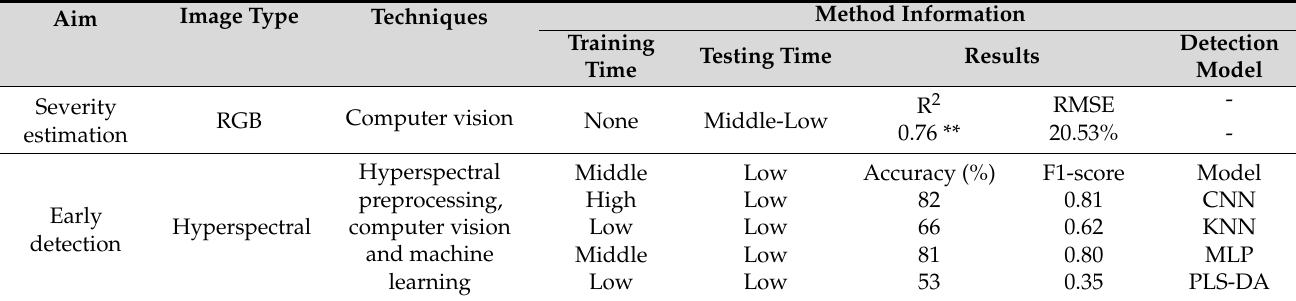
Table 1. Methods and results of severity estimation and early detection of downy mildew in grapevine. Results of the early detection method were selected from the 9th day post inoculation